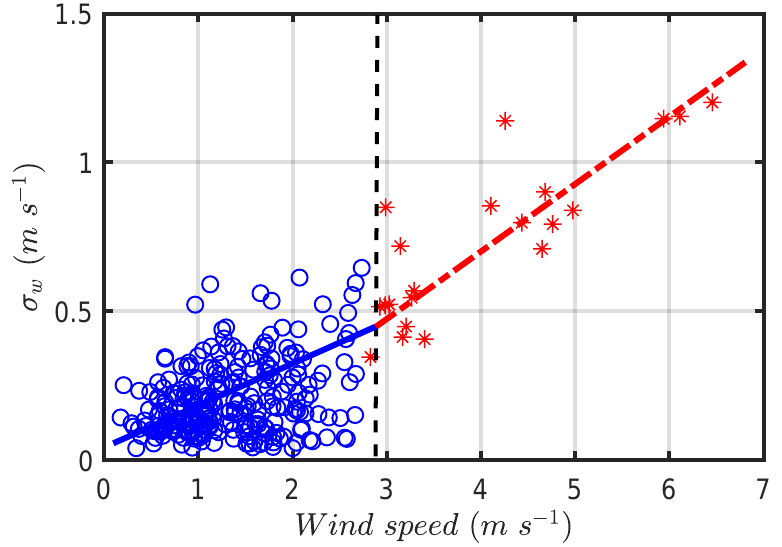
Figure 8. Standard deviation of the vertical wind speed ( σ w ) as a function of the mean horizontal wind speed ( U ). Each point corresponds to averages of 5 min of data. The blue circles and red asterisks correspond to periods of absence and presence of SL2, respectively. The black dashed line indicates the threshold below, where only points belonging to the absence period of SL2 (weak turbulent regime) are found and above that threshold corresponds to periods of the presence of SL2 (strong turbulent regime). The red dashed and blue lines correspond to least squares